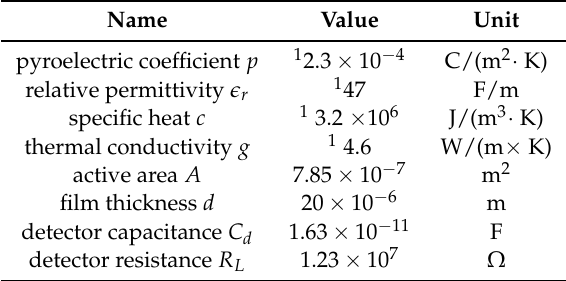
Table 1. Parameters of the LiTaO 3 thin film